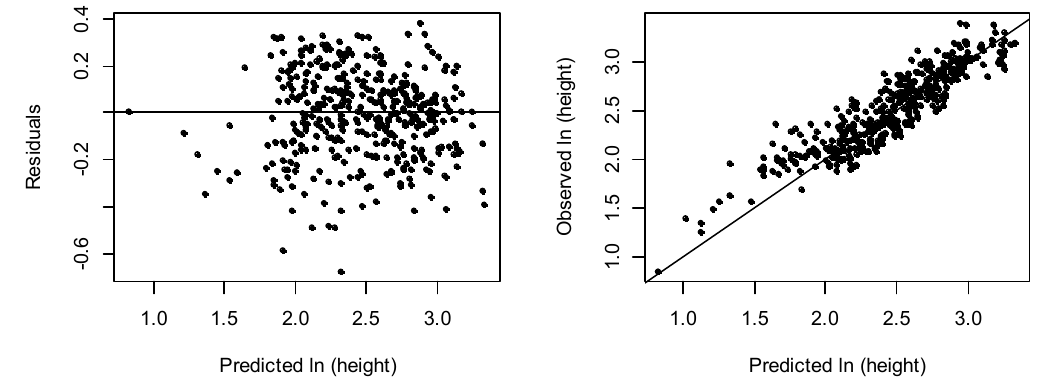
Figure 3. Residuals vs. predicted values and observed vs. predicted values of total height (Equation (2)). Original units are in metres.